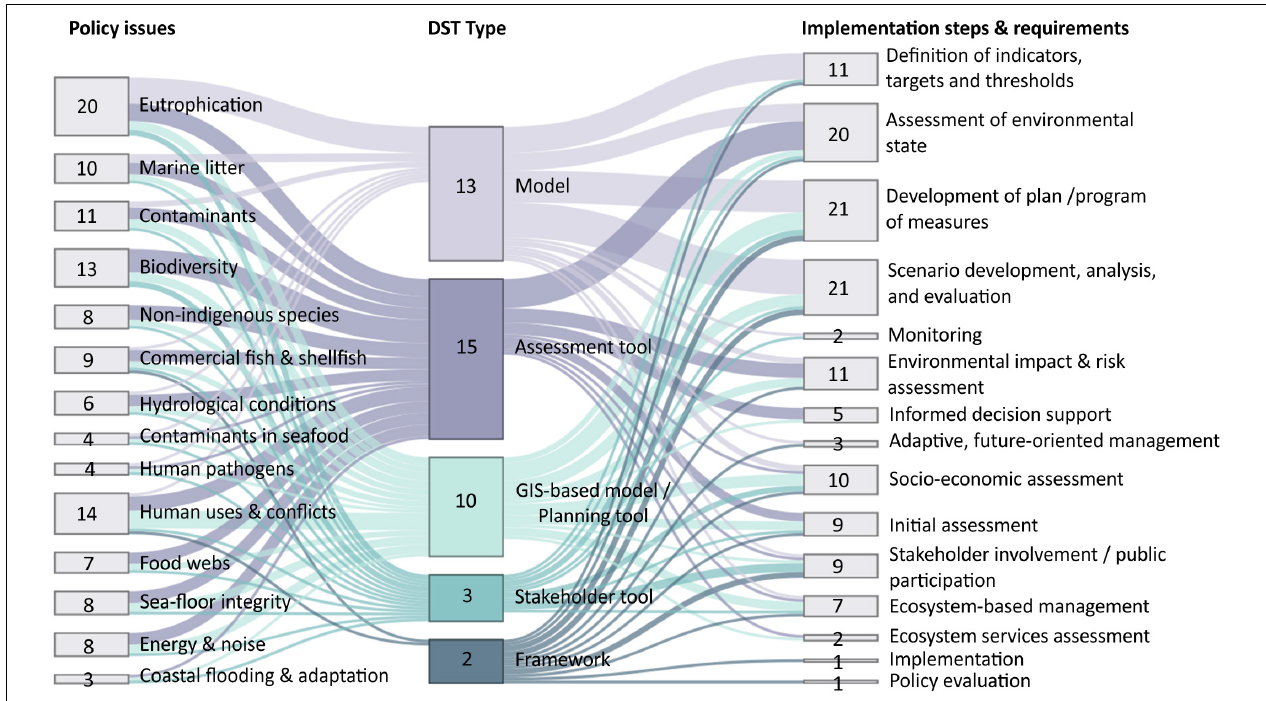
FIGURE 4 | Availability of decision support tools (DST) and DST types for policy issues and implementation steps and requirements based on the DST review.